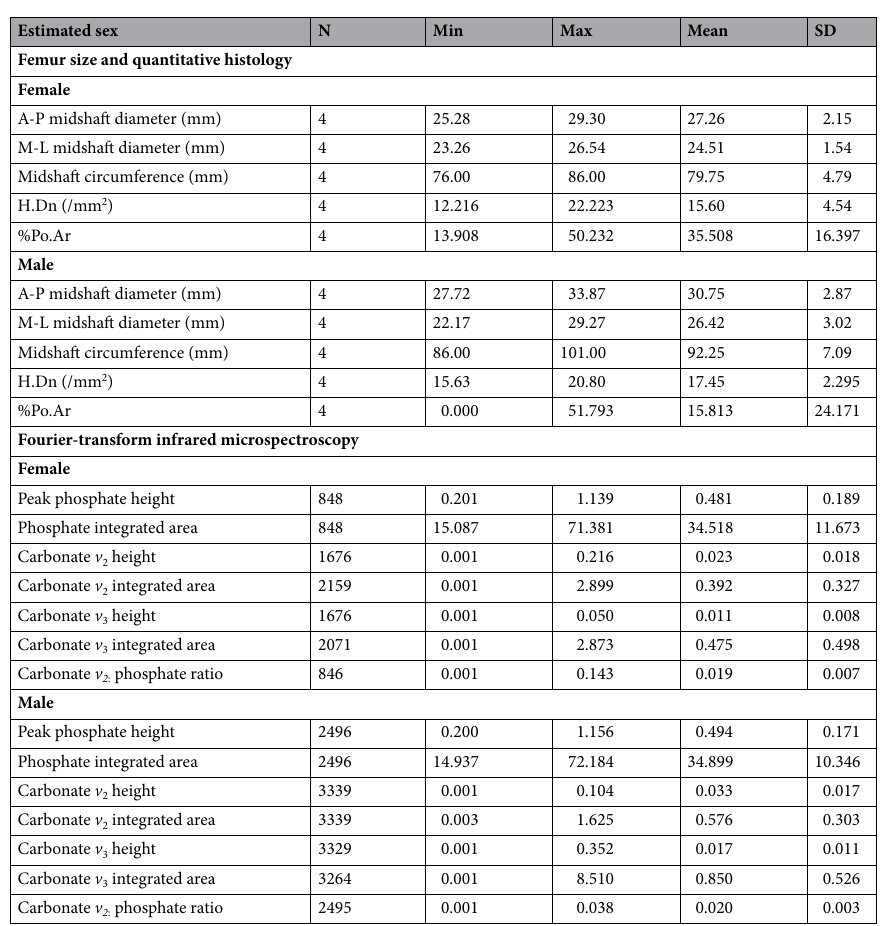
Table 2. Histomorphometry and synchrotron source Fourier-transform infrared microspectroscopy descriptive data per estimated sex (four males and four females). SD: standard deviation, min.: minimum data, max.: maximum data, A-P: antero–posterior, M-L: medio-lateral, H.Dn: Haversian canal density per mm 2 , %Po.Ar: percent area of sample impacted by porosity producing